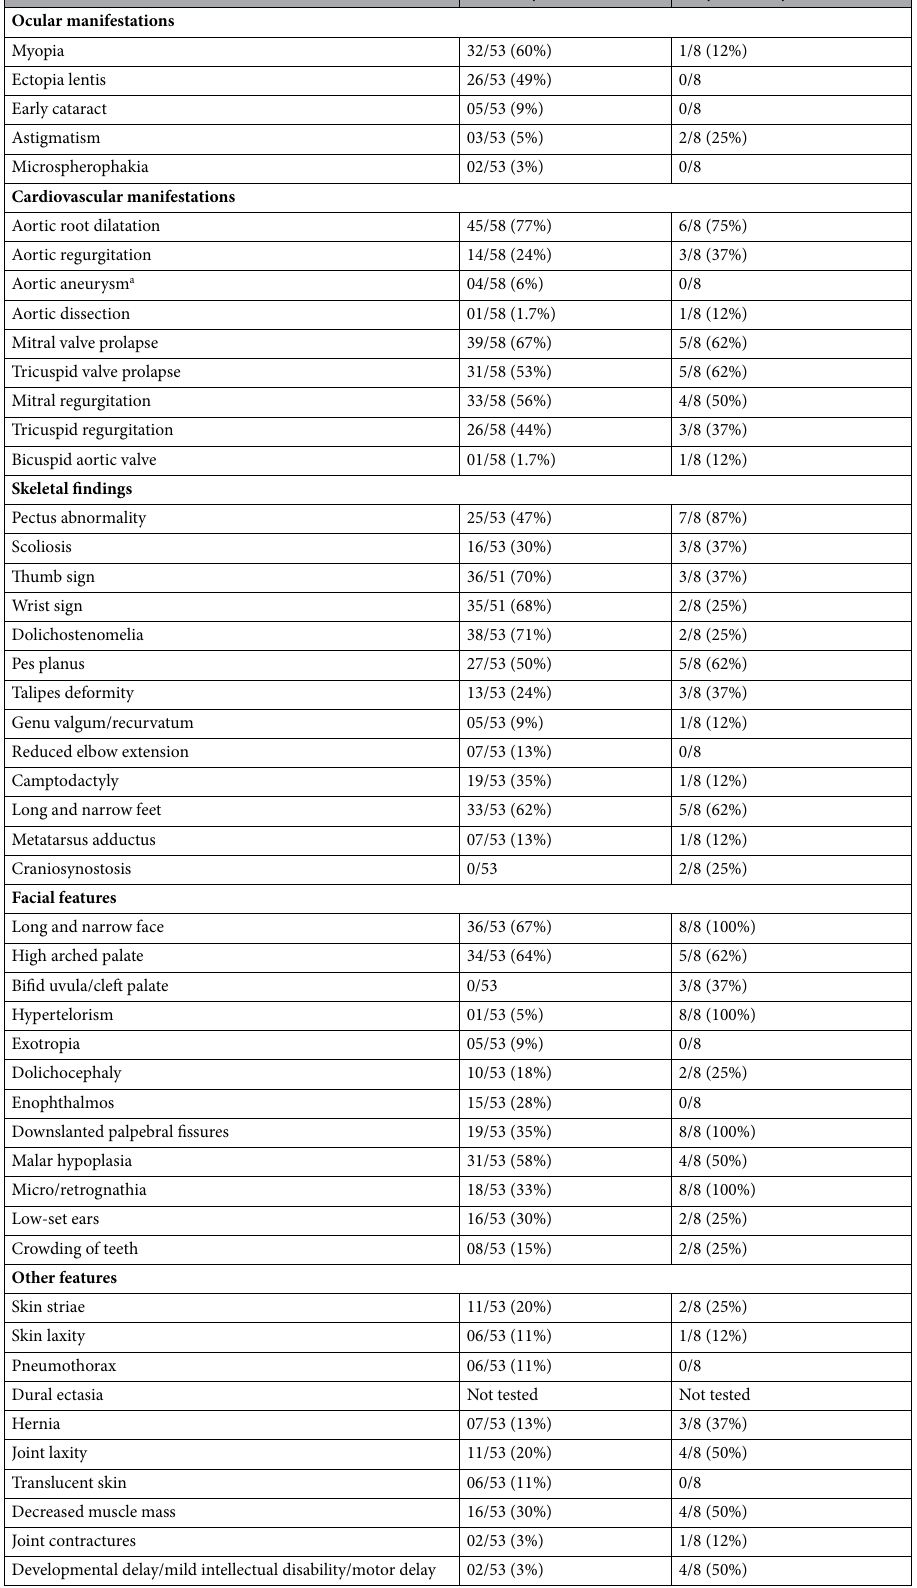
Table 2. Clinical features in patients with Marfan or Loeys–Dietz syndrome and a clinically relevant variant. Numerator indicates the number of individuals with a clinical feature and denominator indicates the number of individuals where information is available for the given clinical feature. a Younger individuals with Loeys– Dietz syndrome might not manifest with aortic